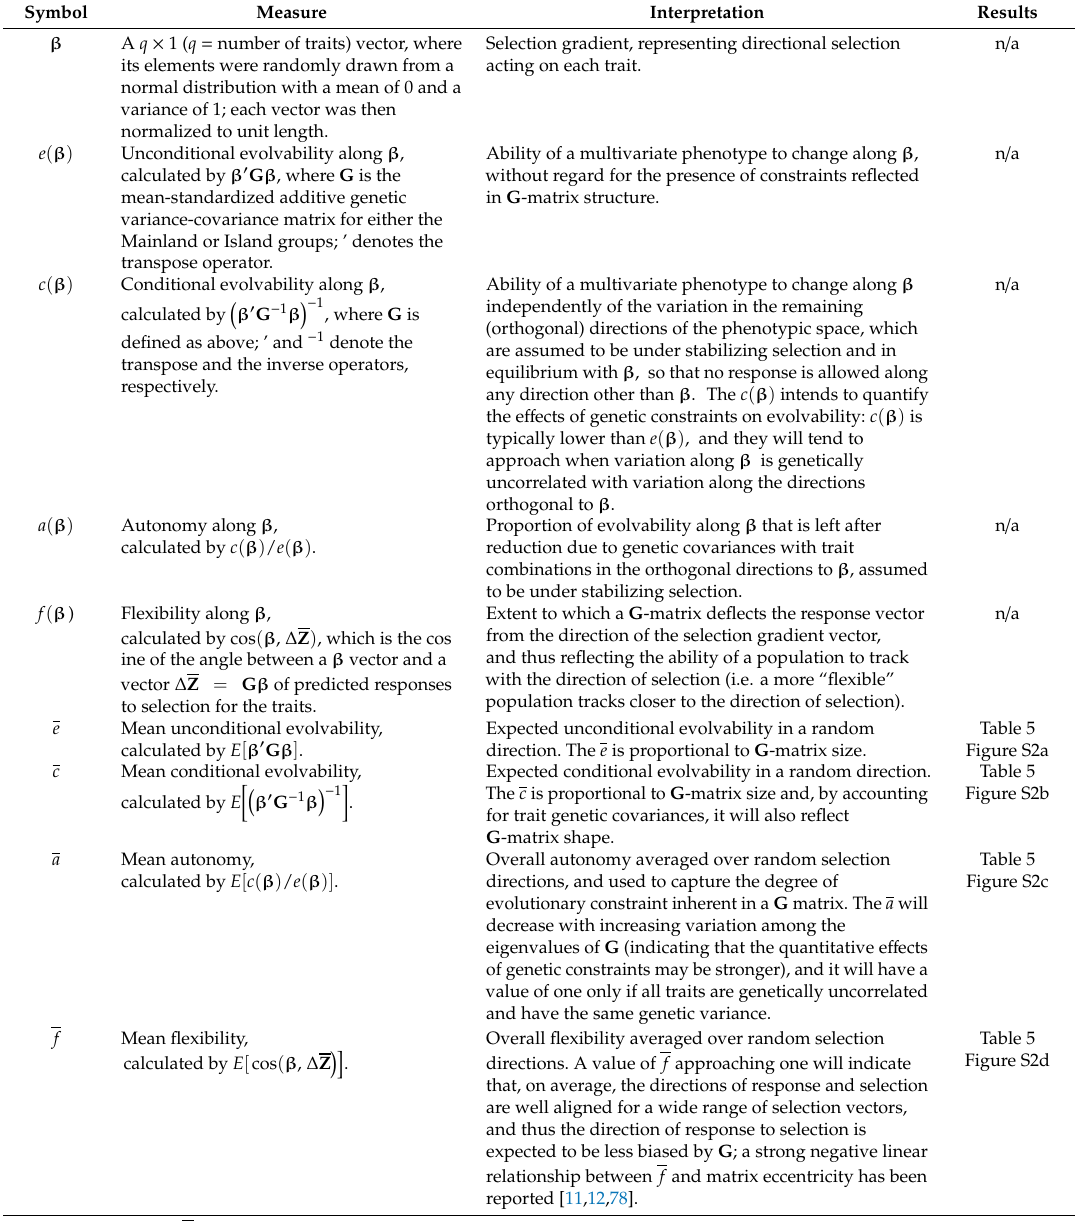
Table 1. Multivariate measures capturing the potential for evolution that were evaluated to compare the Mainland and Island G -matrices.